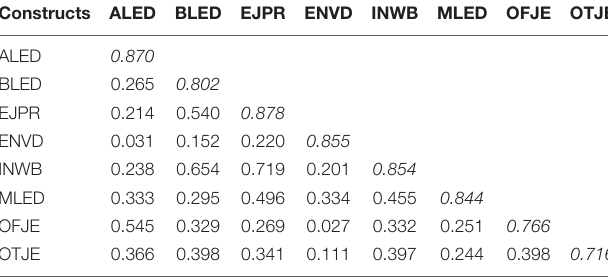
TABLE 2 | Discriminant validity. Constructs ALED BLED EJPR ENVD INWB MLED OFJE OTJE